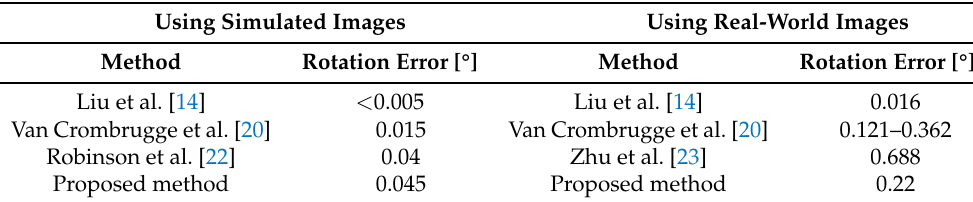
Table 1. Comparison of five state-of-the-art methods. Because the validation experiments vary greatly between the different techniques, the results can not be compared directly. They do, however, indicate the order of magnitude of the obtained